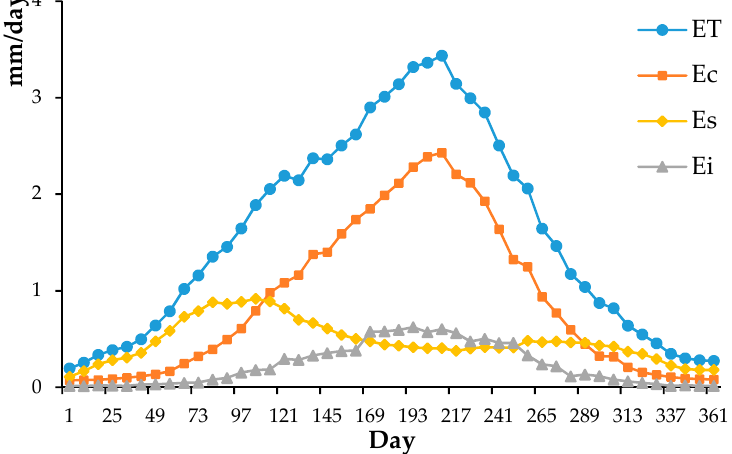
Figure 6. Temporal trends of seasonal variation in Ec, Es, and Ei during 2000–2020. The seasonal variations of daily ET and its components during different impoundment periods are shown in Figure 7. Ec from January to May before impoundment (stage 1) was lower than that after impoundment, but there was no significant difference in Ec among different impoundment stages from June to December. The peak of Ec appeared at the 193rd day before impoundment (stage 1), while it delayed to the 201st day, 209th day, and 217 day for stage 2 to stage 4, respectively, and finally returned to the 209th day at stage 5. Es from February to June was in order: stage 2 > stage 1 > stage 3 > stage 4 > stage 5, and there was little difference in Es among different impoundment stages from June to July. The Es at stage 1 was higher than other stages from July to October, while Es at stage 5 was lower than other stages across the year. After impoundment, Ei increased form 0.20 mm/day at stage 1 to 0.25 mm/day at stage 5, and the increase of Ei was greatest from days 169 to 217, with a 14.0% increase.